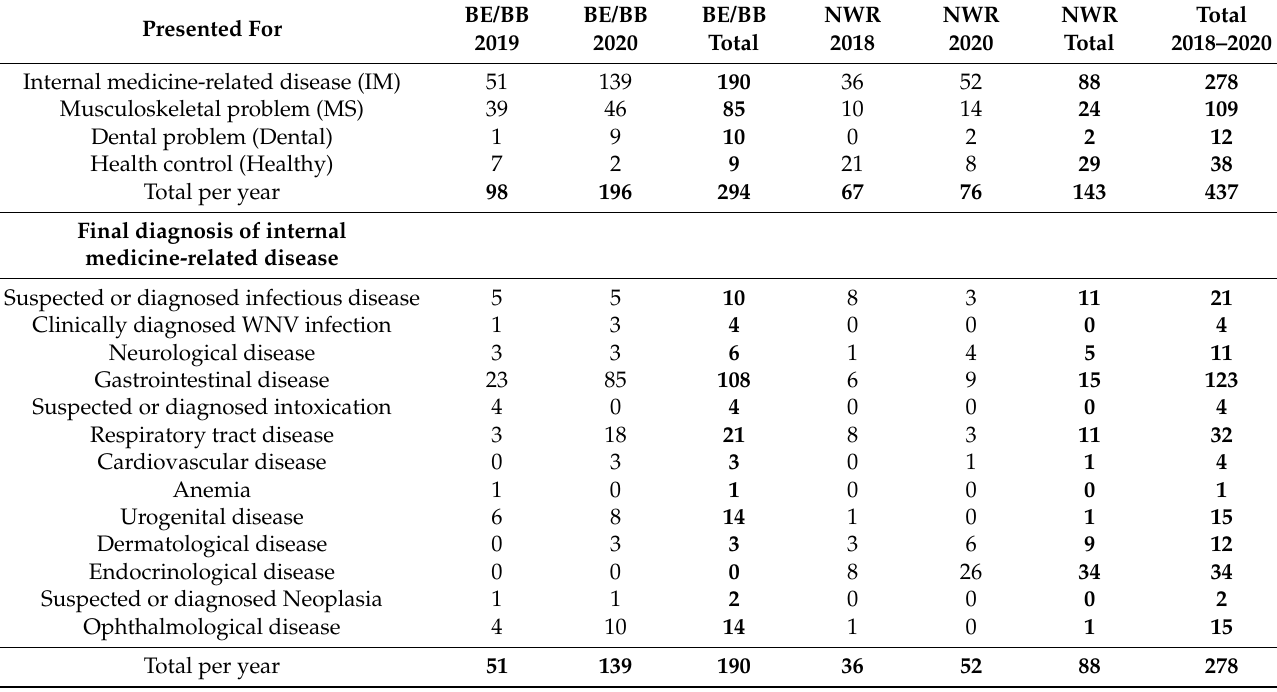
Table 1. Reason for presentation and final diagnosis of the subcategory internal medicine-related disease in the sampled horses from the regions Berlin/Brandenburg (BE/BB/ panel A) and North Rhine–Westphalia (NRW/ panel B). Since the majority of typical WNV symptoms were found in the internal medicine-related disease (IM) category, only this one was further broken down into subcategories in the table.